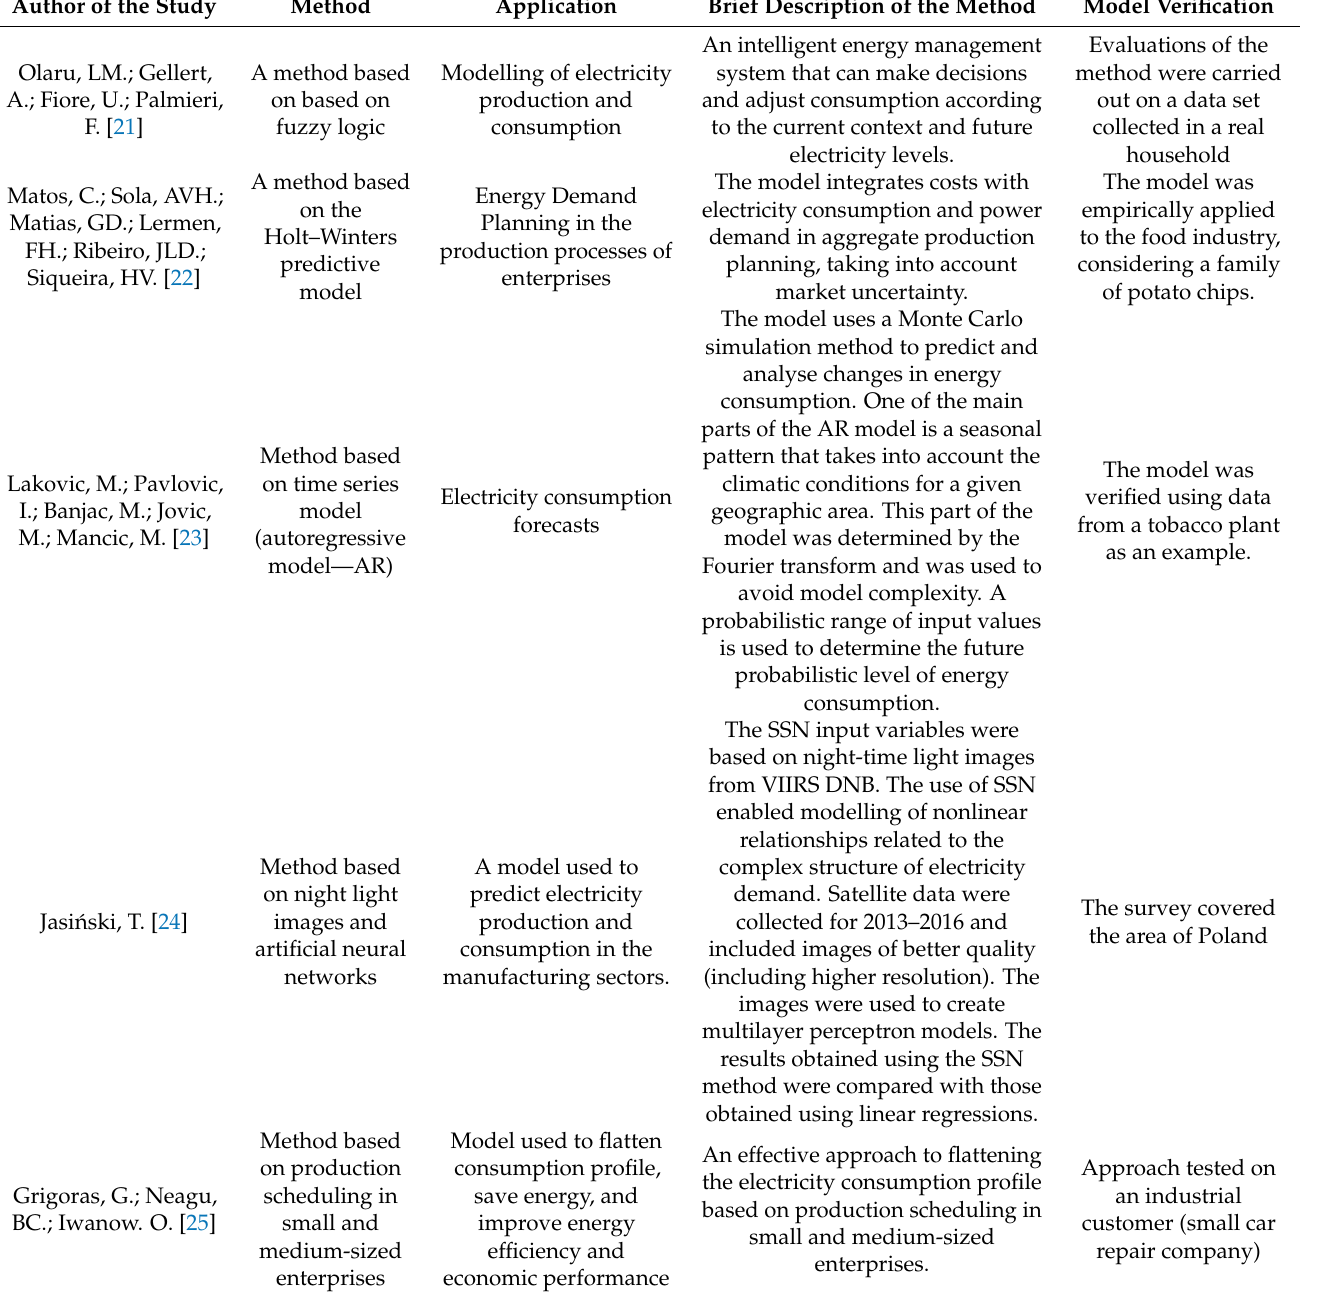
Table 1. Characteristics of the methods used to manage energy